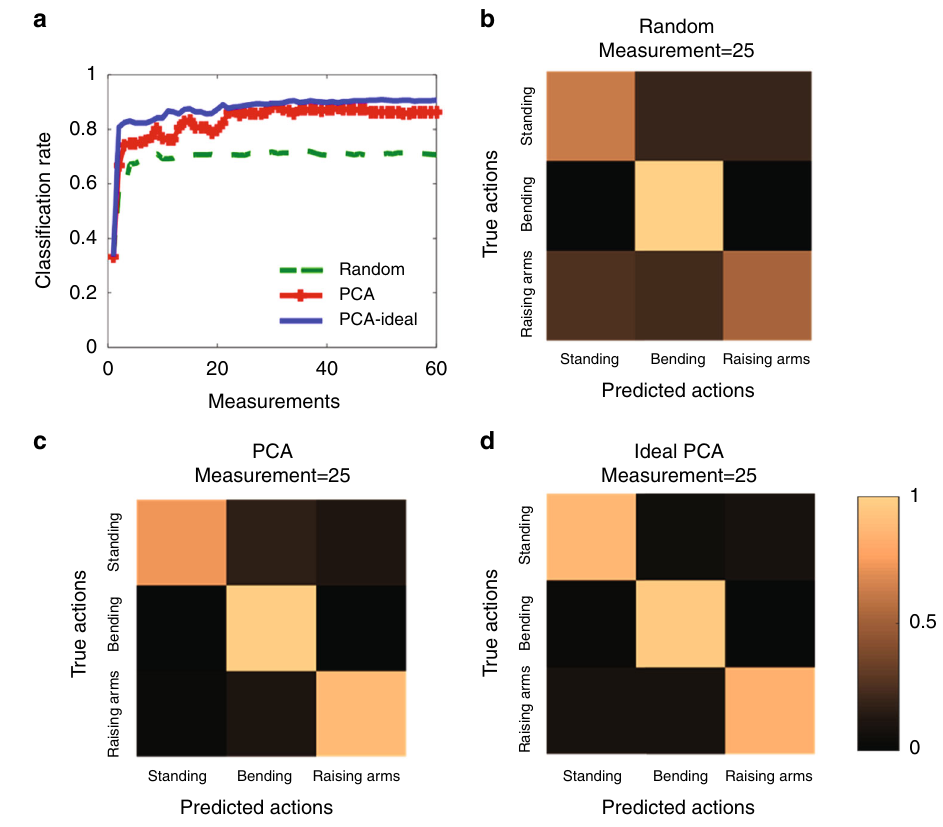
Fig. 4 Classifying body gestures with the proposed imager. a Classi fi cation rate versus number of measurements when the programmable metasurface is trained by random projection and PCA. For comparison, the corresponding results by theoretical PCA (blue line) are also provided. b – d The comparison of speci fi c classi fi cation results by ( b ) random projection, ( c ) PCA, and ( d ) theoretical PCA, in which 25 measurements are